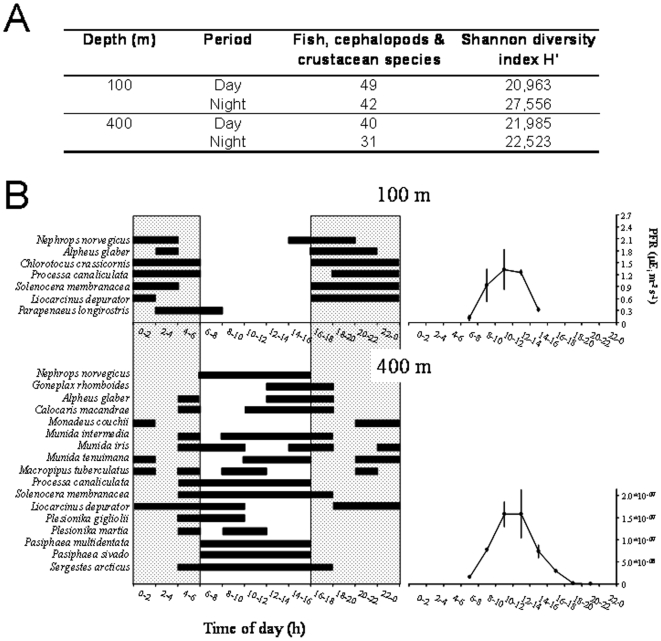
Diel difference in biodiversity estimates obtained with trawling in the Mediterranean Sea.Reported diel differences in estimated biodiversity are obtained by two trawl hauls performed at the autumnal equinox at midday and midnight, in the same sampling location of the western Mediterranean shelf (100 m) and slope (400 m), during October 1999 (NERIT survey). (A) Number of fish, crustaceans, and cephalopod species, and Shannon diversity index (H'), and (B) Waveform analysis of four-day time series of data for catches (left) and light intensity variations as photon fluency rate (PFR; right) for representative decapods. Black rectangles depict the temporal limits of significant increases in catches. Shaded gray rectangles indicate the night duration [adapted from 425].